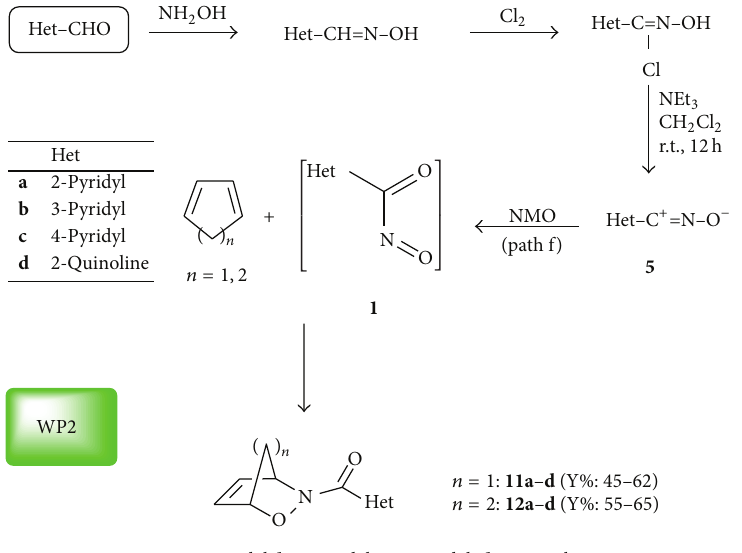
Scheme 3: Application of the WP2 protocol to the synthesis of nitrosocarbonyl HDA cycloadducts 11a – d and 12a – d from heteroaromatic nitrile